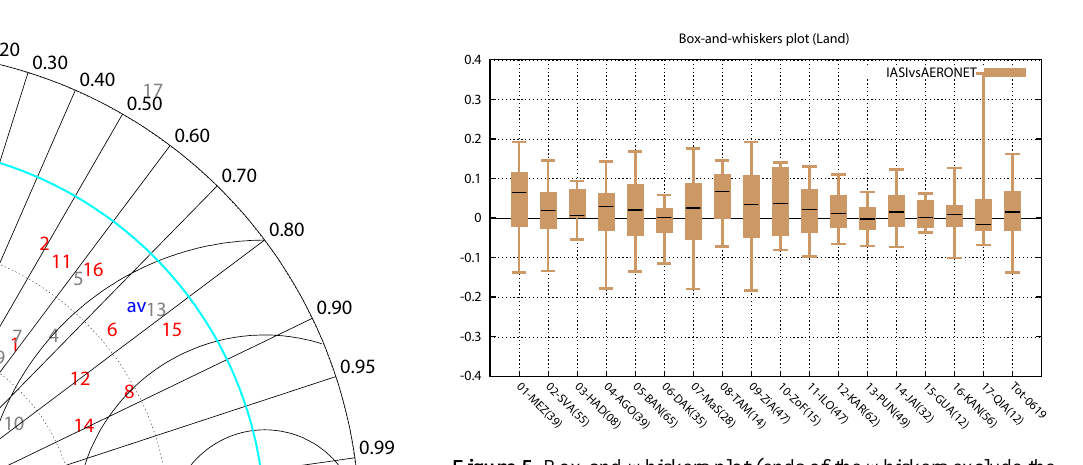
Figure 5. Box-and-whiskers plot (ends of the whiskers exclude the outliers) for the difference between IASI and AERONET 500nm coarse-mode AOD (scaled by the site ratio as explained in Sect. 3) over land. Sites are identified by their number and code in Table 3, followed by the number of items. Last box marked “Tot”: overall